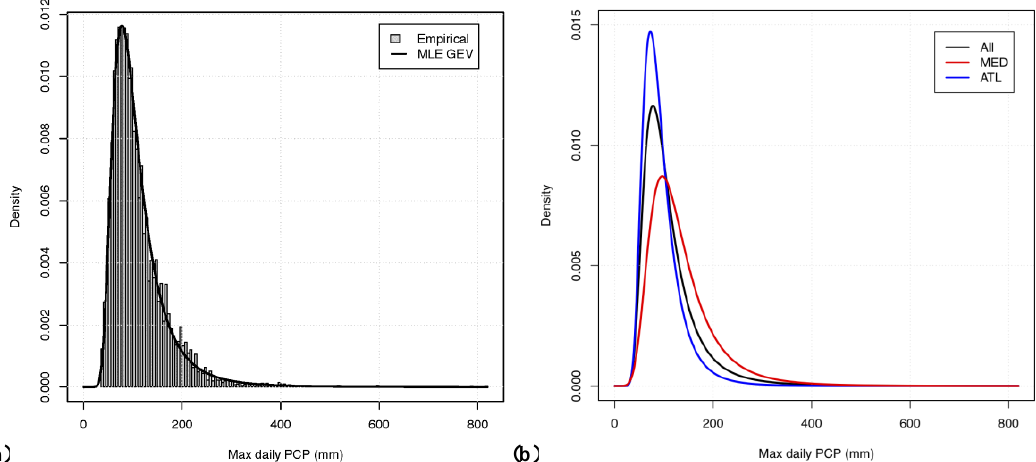
Figure 7.- a) Empirical histogram of record daily precipitation values for all the rain gauges in the database and the corresponding fitted GEV distribution. Fitted parameters are provided (median) in Table 3. b) Comparison of GEV distributions fitted to all stations in the database (ALL), mediterranean sites (MED) and atlantic stations (ATL).